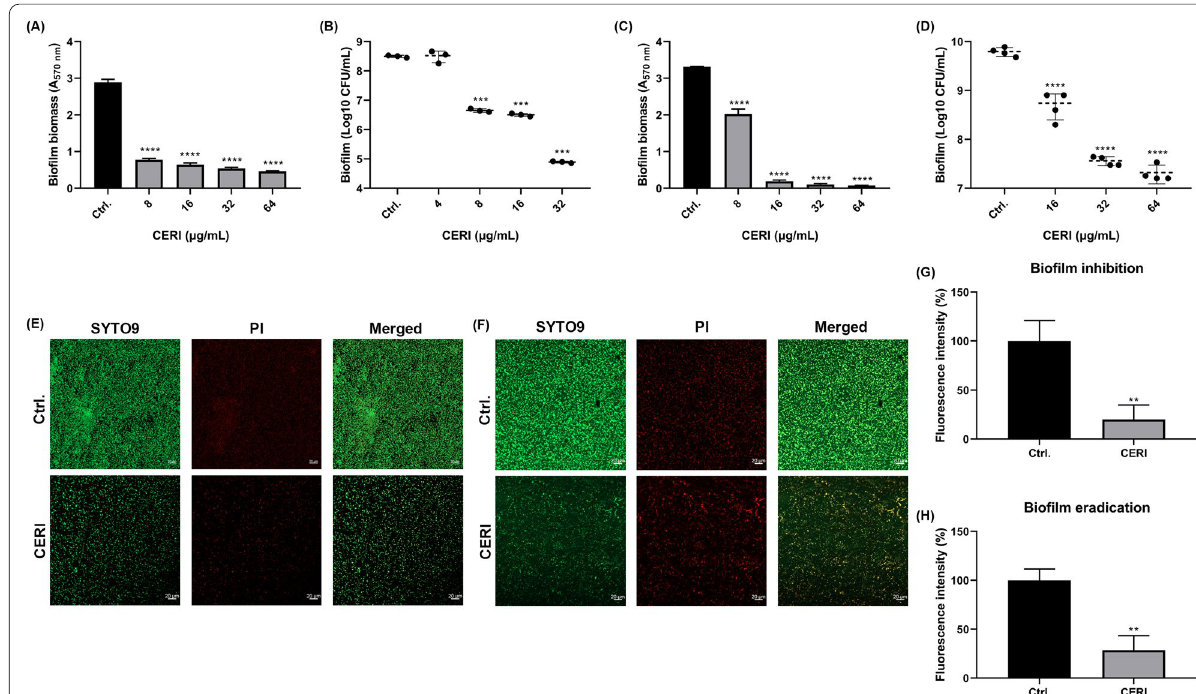
Fig. 1 Anti-biofilm effects of CERI against S. aureus . Dose-dependent biofilm inhibition effect of CERI was determined using 0.25% crystal violet staining ( A ) and viable cell counting assay ( B ) after exposure for 24 h. Dose-dependent biofilm eradication effect of CERI was determined using 0.25% crystal violet staining ( C ) and viable cell counting assay ( D ) after forming mature biofilm and exposure for 24 h. STYO 9 and PI staining of MRSA ATCC 43300 in biofilm inhibition ( E ) and eradication ( F ) were observed by CLSM ( 40) after exposure in CERI or DMSO for 30 min. Scale × bars, 20 μm. Fluorescence intensity quantification analysis of the total biofilm biomass of biofilm inhibition ( G ) and biofilm eradication ( H ). The experiments were carried out in three biological repeats, and results correspond to average SD. The data were analyzed using one-way ANOVA ± with Dunnett’s multiple comparison test. Results were considered highly significant when *** P < 0.001 and **** P <